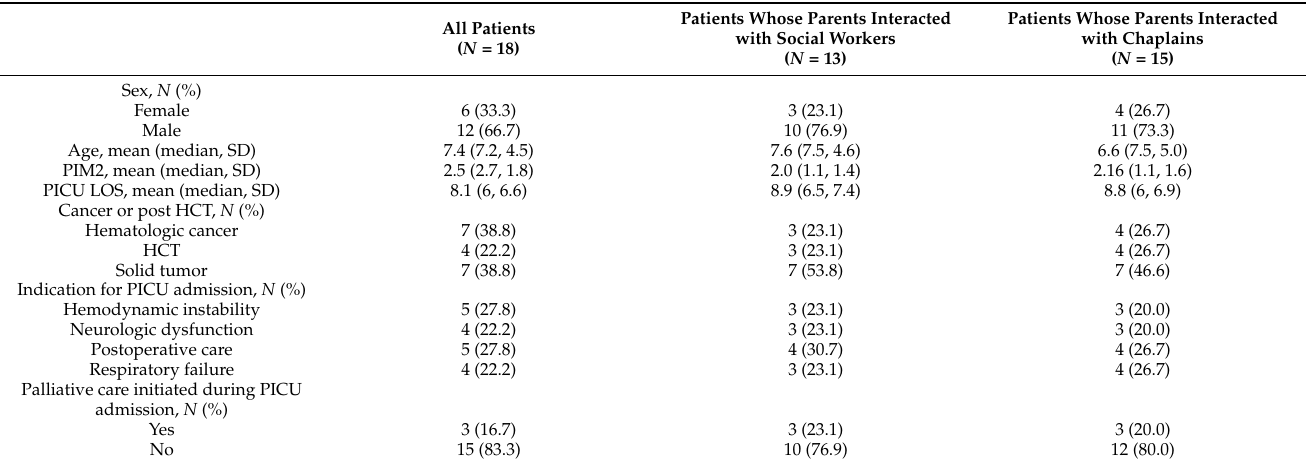
Table 2. Patient demographic and clinical